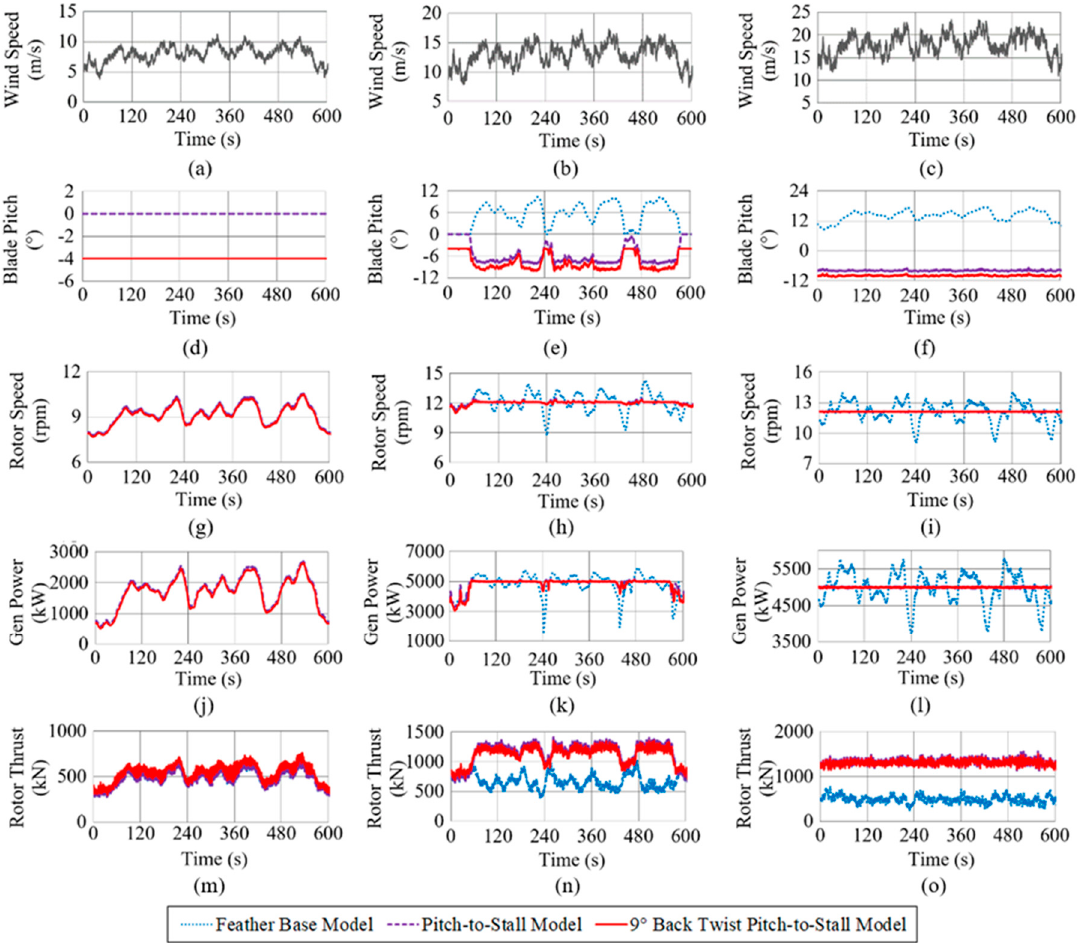
Figure 7. Simulation outputs for pitch-to-feather and pitch-to-stall blade models without and with 9 ◦ back twist at 8 (left), 13 (center), and 18m / s (right) mean turbulent winds. ( a ) wind speed, m / s (8mps); ( b ) wind speed, m / s (13mps); ( c ) wind speed, m / s (18mps); ( d ) blade pitch, ◦ (8mps); ( e ) blade pitch, ◦ (13mps); ( f ) blade pitch, ◦ (18mps); ( g ) rotor speed, rpm (8mps); ( h ) rotor speed, rpm (13mps); ( i ) rotor speed, rpm (18mps); ( j ) generator power, kW (8mps); ( k ) generator power, kW (13mps); ( l ) generator power, kW (18mps); ( m ) rotor thrust, kN (8mps); ( n ) rotor thrust, kN (13mps); ( o ) rotor thrust,